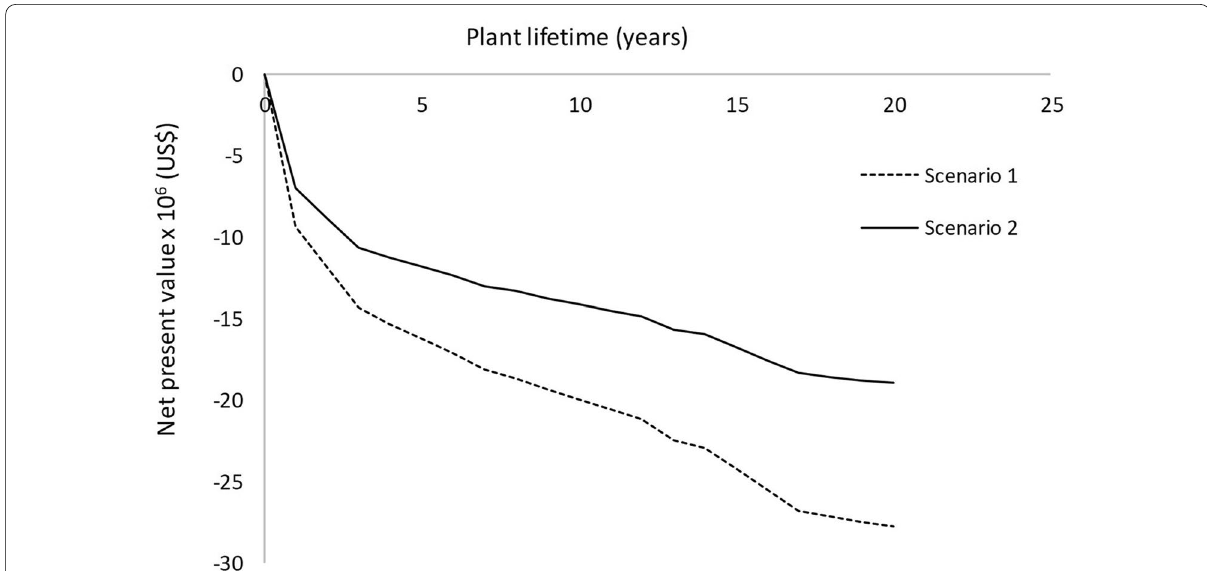
Fig. 1 Net present value (NPV) of the bacterial P3HB production process throughout the plant´s lifetime for both